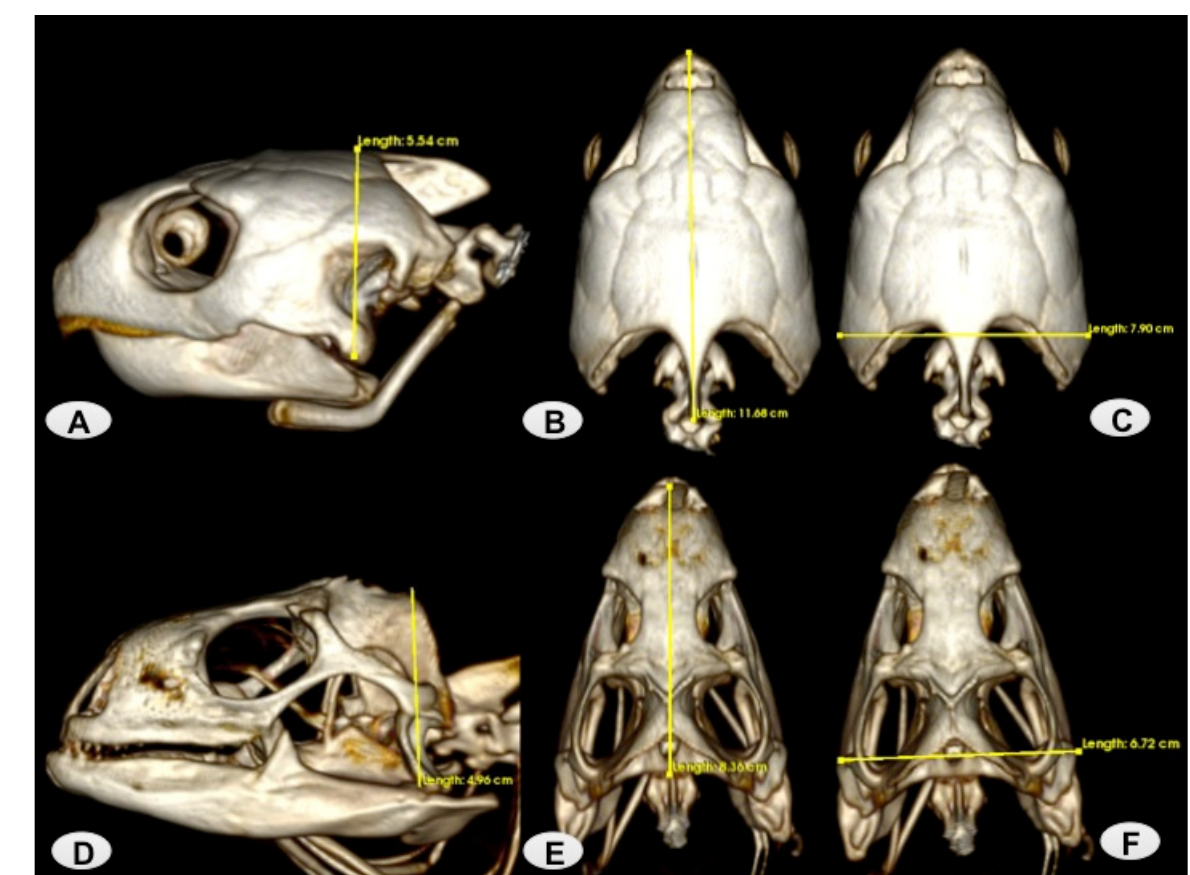
Figure 1. Measurements of the loggerhead turtle and green iguana Head. ( A ) Example of HH in a loggerhead turtle lateral VR image. ( B , C ) Examples of HL and HW in loggerhead dorsal VR images. ( D ) Example of HH in a green iguana lateral VR image. ( E , F ) Examples of HL and HW in green iguana dorsal VR images.